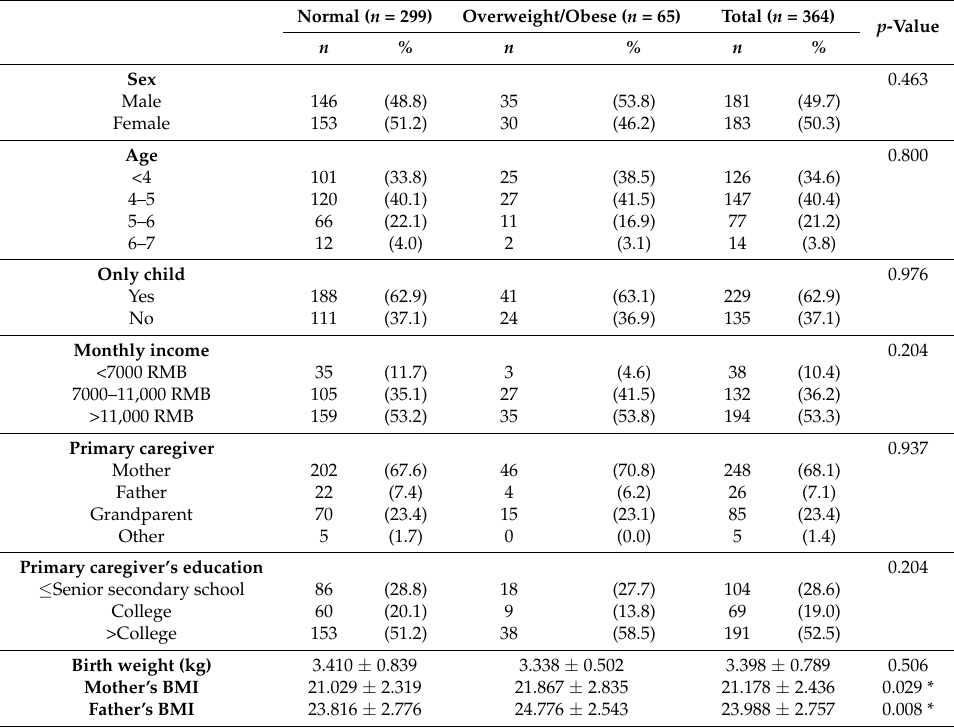
Table 1. Demographic and household characteristics of participants by weight status.